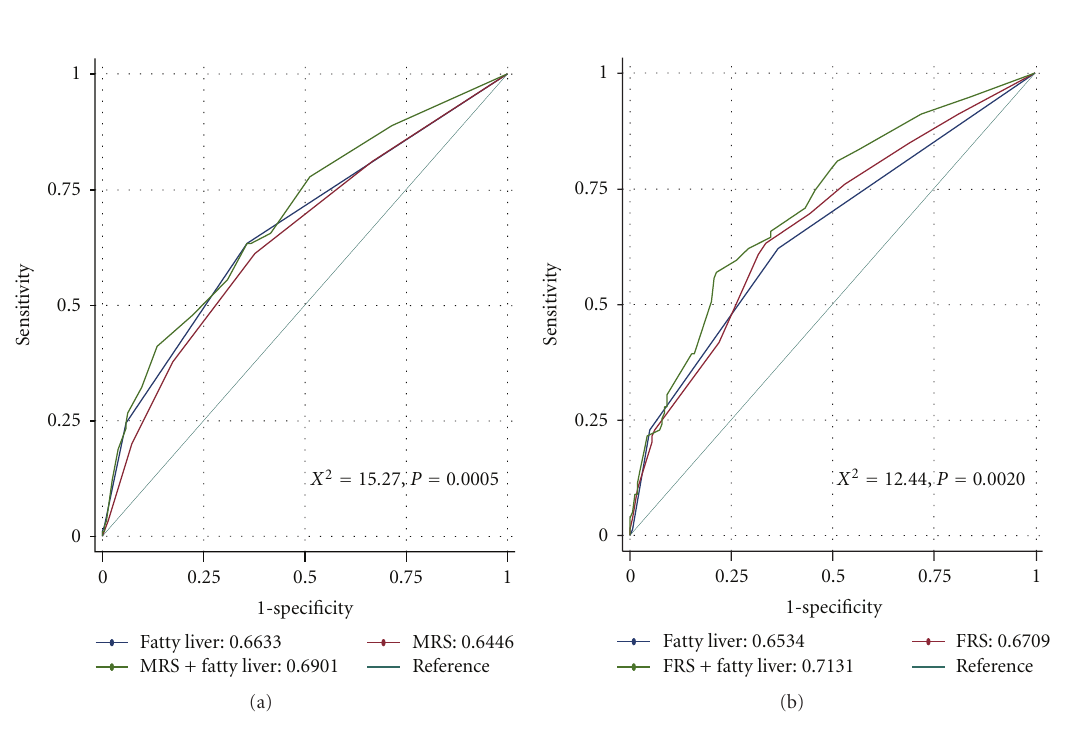
Figure 2: Receiver operating characteristic curves demonstrated by both metabolic or Framingham risk scores and superimposed by fatty liver disease in predicting coronary calcium deposition. When presence of fatty liver disease was added on traditional cardiovascular risk scores, there was significant increase in the area under